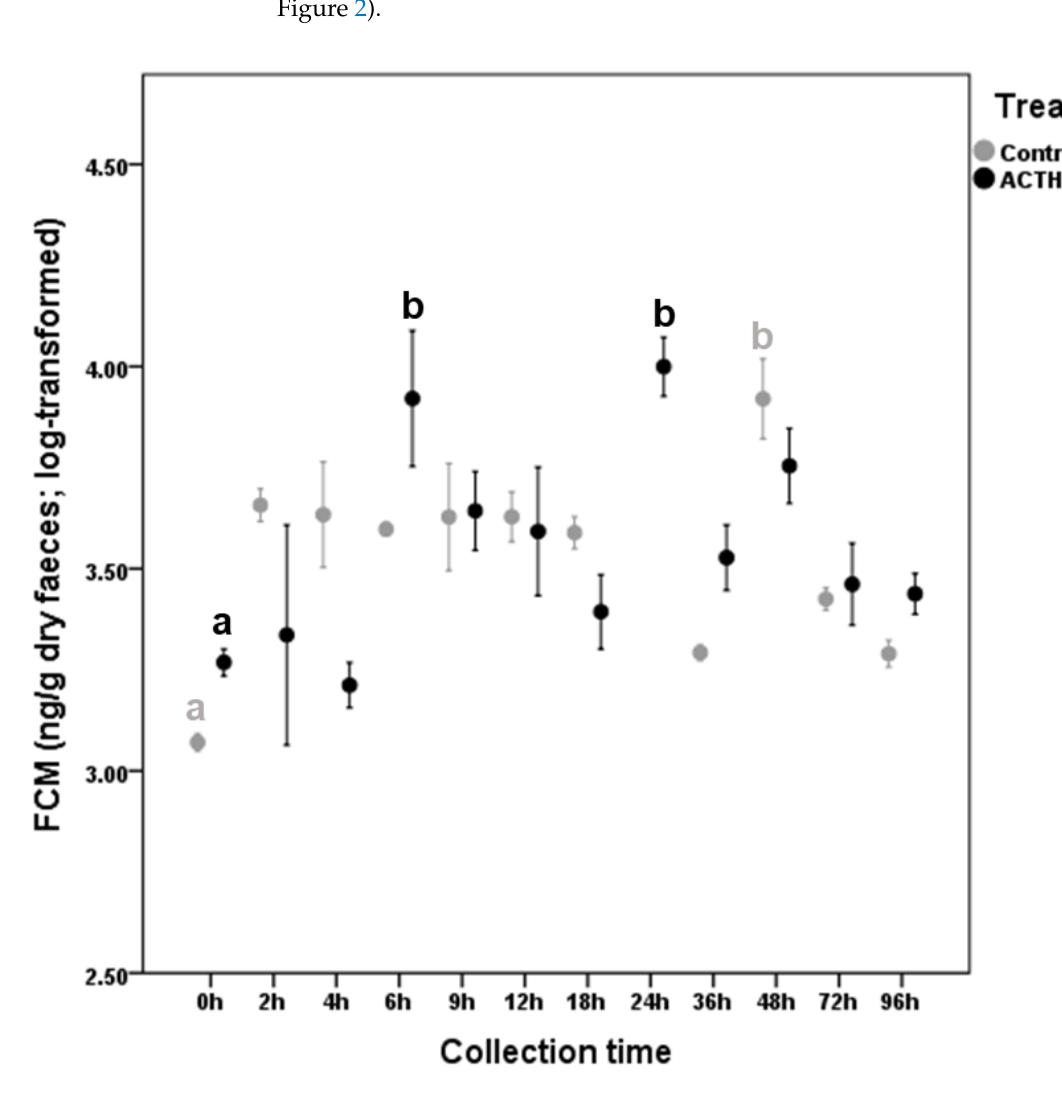
Figure 2. Fecal Corticosterone Metabolite variation (mean ± SE) in G. gerbillus (only males) after ACTH (adrenocorticotropic hormone) ( n = 3) or saline solution ( n = 3) injection. Significant differences between basal (right before the injection) and peak FCM (fecal corticosterone metabolites) values are indicated with different small letters.